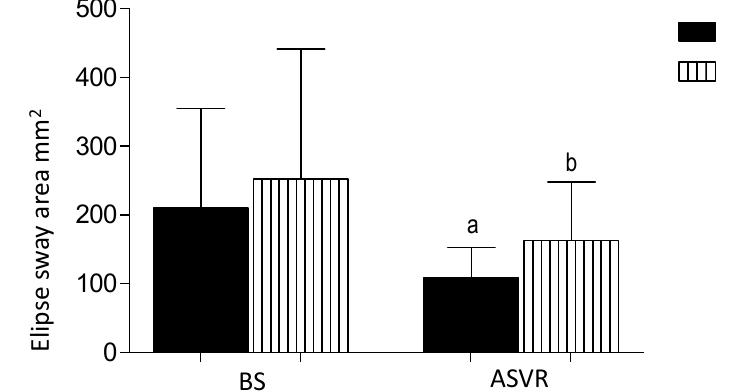
Figure 6. Vitamin D supplementation had no effects on the rehabilitation-induced improvement on the ellipse sway area (mm 2 ) of patients after anterior cervical interbody fusion surgery. Columns, mean and bars, standard deviations (SDs). a, p < 0.05, significantly different compared with D3-BS and b, p < 0.05, significantly different compared with Pl-BS by one-way ANOVA.